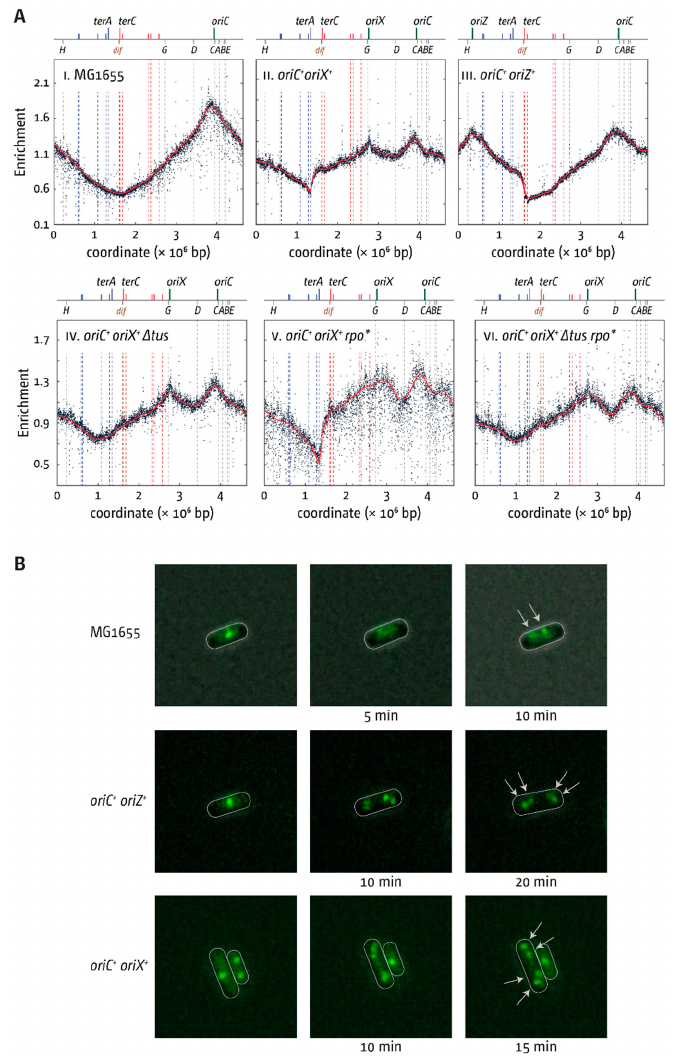
Figure 3. Replication dynamics in E. coli cells with one and two replication origins. ( A ) Marker frequency analysis (MFA) of E. coli oriC + , oriC + oriX + , and oriC + oriZ + cells, and impact of ∆ tus and an rpo* point mutation on these cells. The number of reads (normalised against reads for a stationary phase wild-type control) is plotted against the chromosomal location. A schematic representation of the E. coli chromosome showing positions of oriC and oriX (green line) and ter sites (above), as well as dif and rrn operons A–E, G, and H (below), is shown above the plotted data. The strains used were MG1655 ( oriC + ), RCe504 ( oriC + oriZ + ), JD1181 ( oriC + oriX + ), JD1203 ( oriC + oriX + ∆ tus ), JD1190 ( oriC + oriX + rpo* ), and JD1205 ( oriC + oriX + ∆ tus rpo* ). ( B ) Visualisation of replisomes (Ypet-DnaN) in wild-type, oriC + oriX + , and oriC + oriZ + cells. Cells were grown in M9 minimal salts medium with 0.2% glucose and transferred onto a thin agarose pad of the same medium on a microscopy slide (see Material and Methods). Slides were transferred into a chamber heated to 37 ◦ C and fluorescent foci in single cells tracked over time. The strains used were AS1062 ( ypet-dnaN ), RCe749 ( oriC + oriZ + ypet-dnaN ), and RCe751 ( oriC + oriX + ypet-dnaN